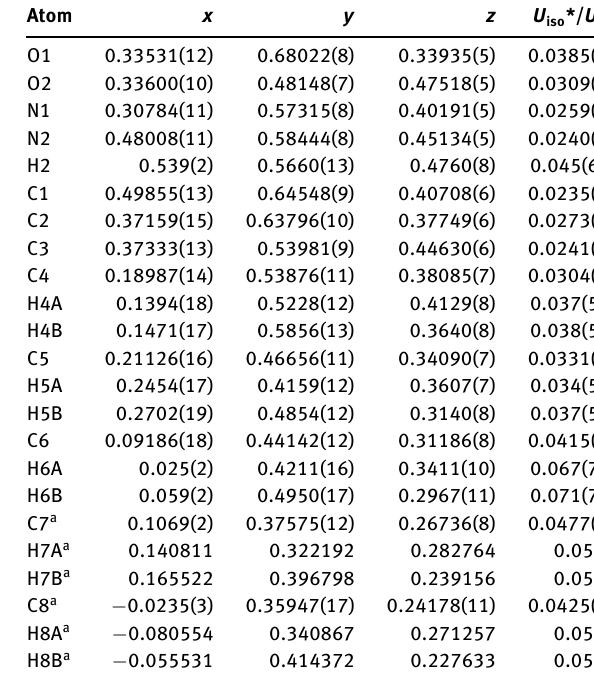
Table 2: Fractional atomic coordinates and isotropic or equivalent isotropic displacement parameters (Å 2